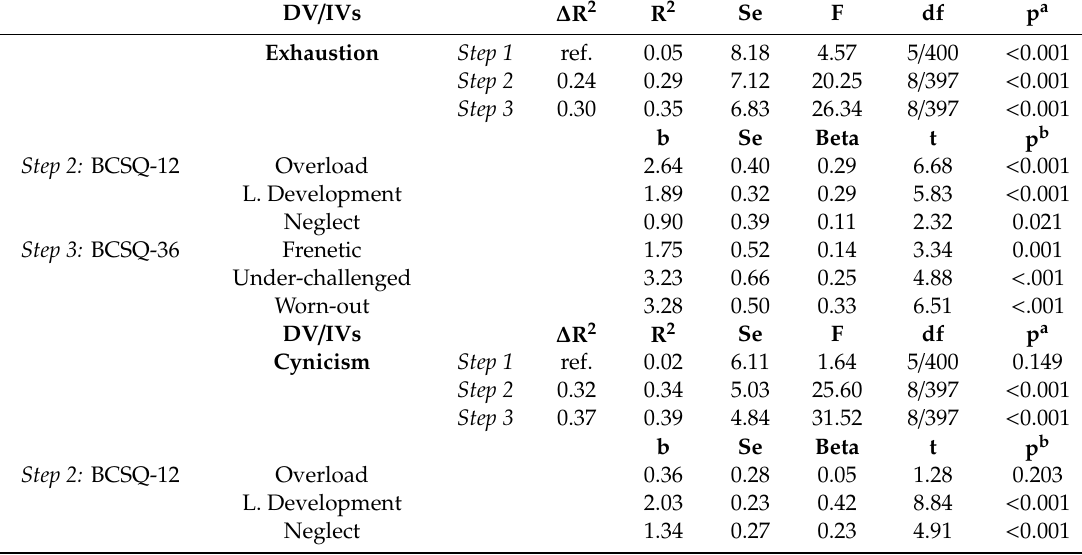
Table 7. Explanatory power of the BCSQ on the classical burnout dimensions. DV /